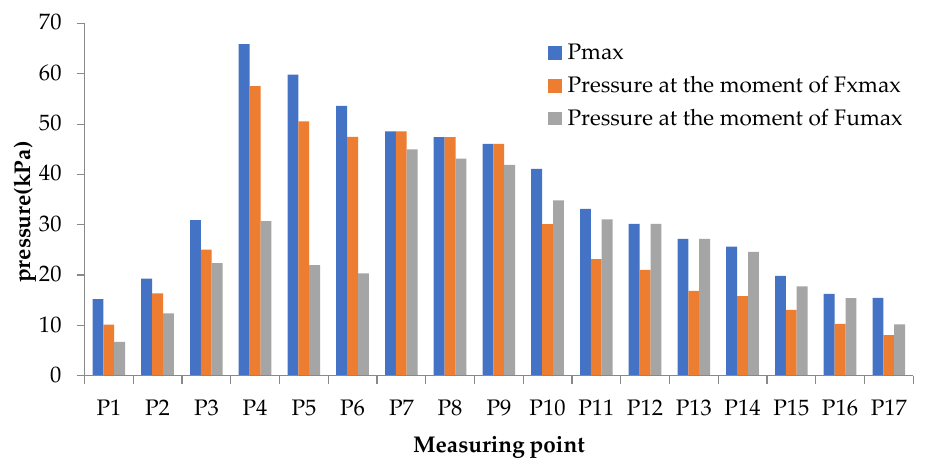
Figure 7. Synchronization rate of P i and P max at the time of the maximum wave force.